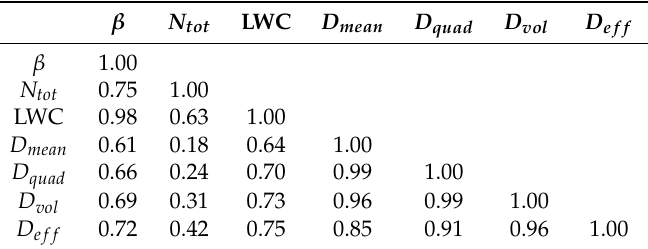
Table 2. Correlation coefficient between each